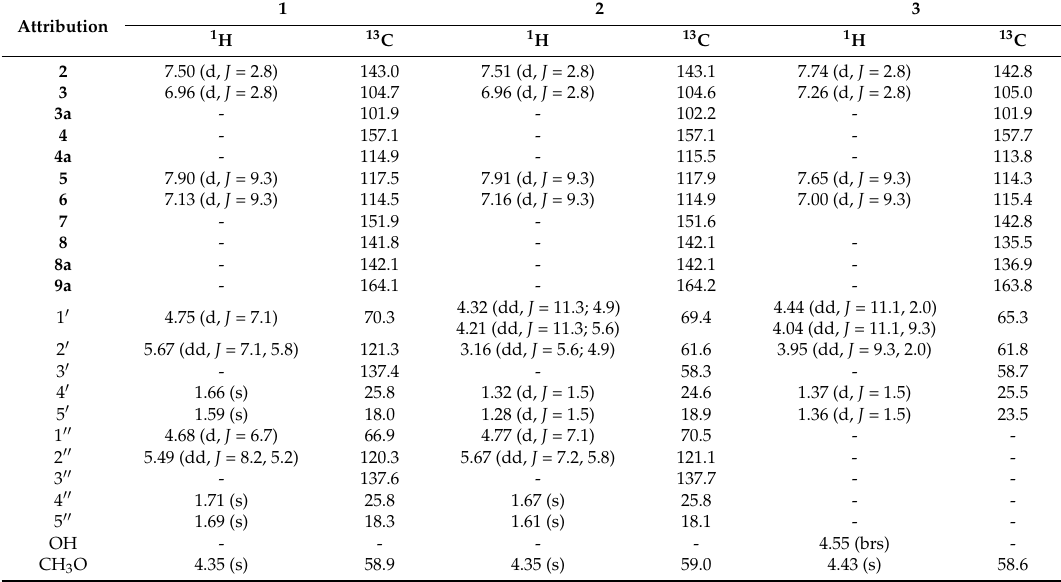
Table 1. 1 H (500 MHz) and 13 C (125 MHz) NMR assignments for ( 1 – 3 ) in CDCl